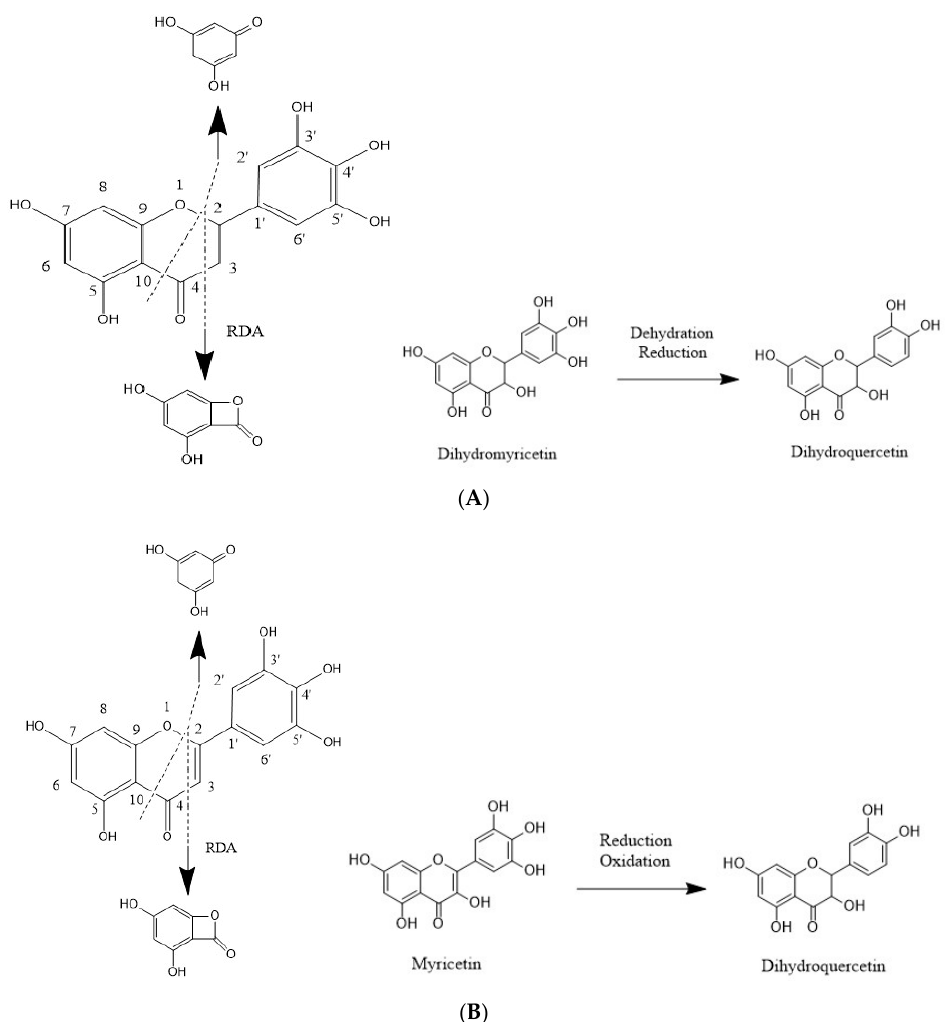
Figure 4. The proposed fragmentation pathways of the metabolite M1 from dihydromyricetin ( A ) and myricetin ( B ), respectively.